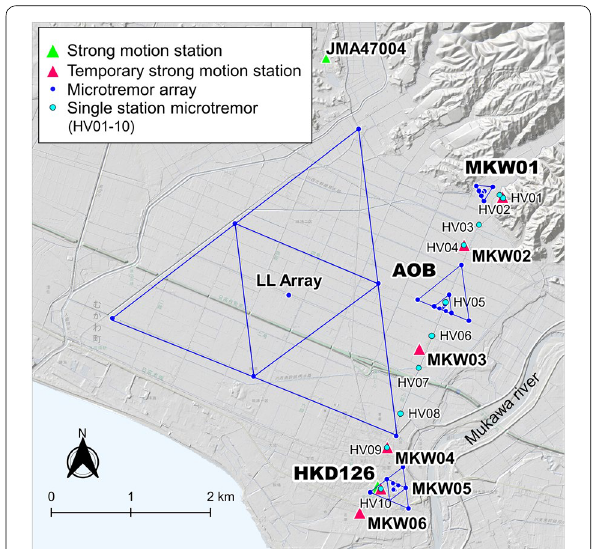
Fig. 5 Locations of temporary strong motion and microtremor observations sites. The red triangles denote the temporary strong motion stations (MKW01-06), the blue circles and lines denote the microtremor array observation points, and the light blue circles denote the single station microtremor observation points (HV01-10).